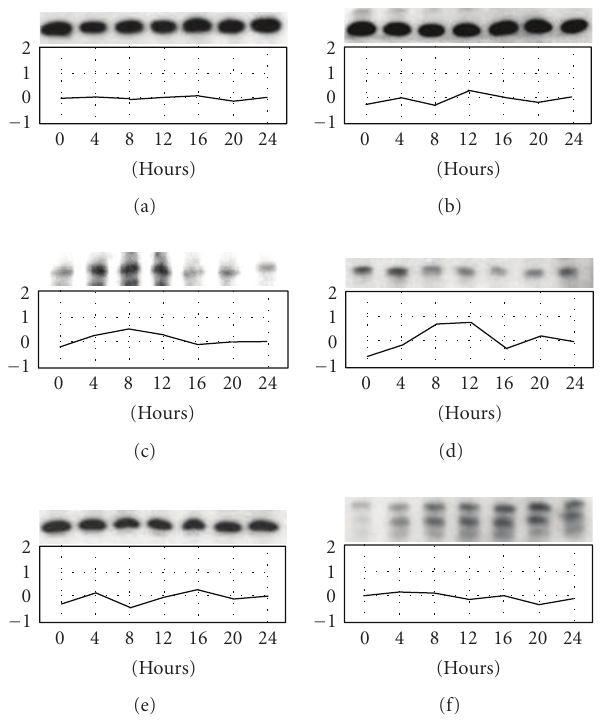
Figure 2: Comparison of results obtained with microarray and pro- tein blot analysis for changes in protein levels during C. neoformans infection. Protein levels at various time points ( top panel ) relative to the mRNA levels in microarray analysis ( bottom panel ) are shown for the following genes: (a) β -actin, (b) Bcl-x, (c) CD47, (d)